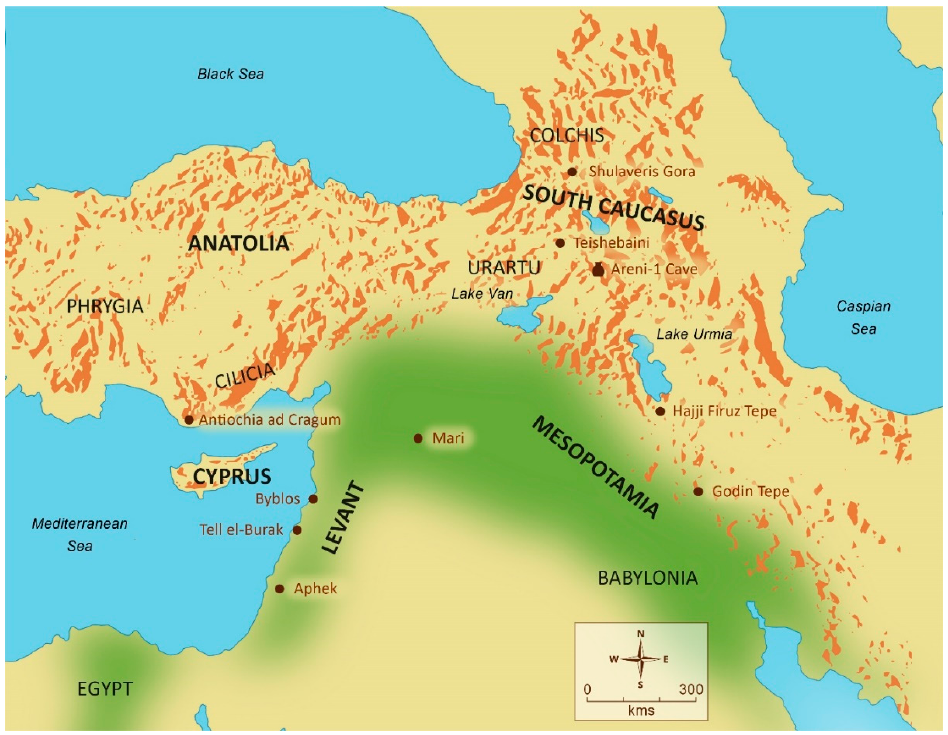
Figure 1. Regions and locations related to the onset of winemaking (adapted by M. Harutyunyan). In southern Armenia, the oldest known wine production facility in the world was discovered, dating back 6100 years. Excavations at the Areni-1 site were carried out in 2007 and 2010 [1,9,10]. Areni-1 is described as a large karst cave with three chambers located on the left side of the Arpa River basin in the eastern part of the village of Areni in Vayots Dzor province. Finds in the cave include two well-preserved cylindrical bread ovens, grain, wine storage vessels, wine-soaked sherds, drinking cups, associated pottery, glass fragments, organic remains, and other small finds (Figure 2). The cave contains archeological cultural layers dating from the Neolithic to the Late Medieval period, with the most important finds dating from the Chalcolithic (5500–3400 cal BC) [9].